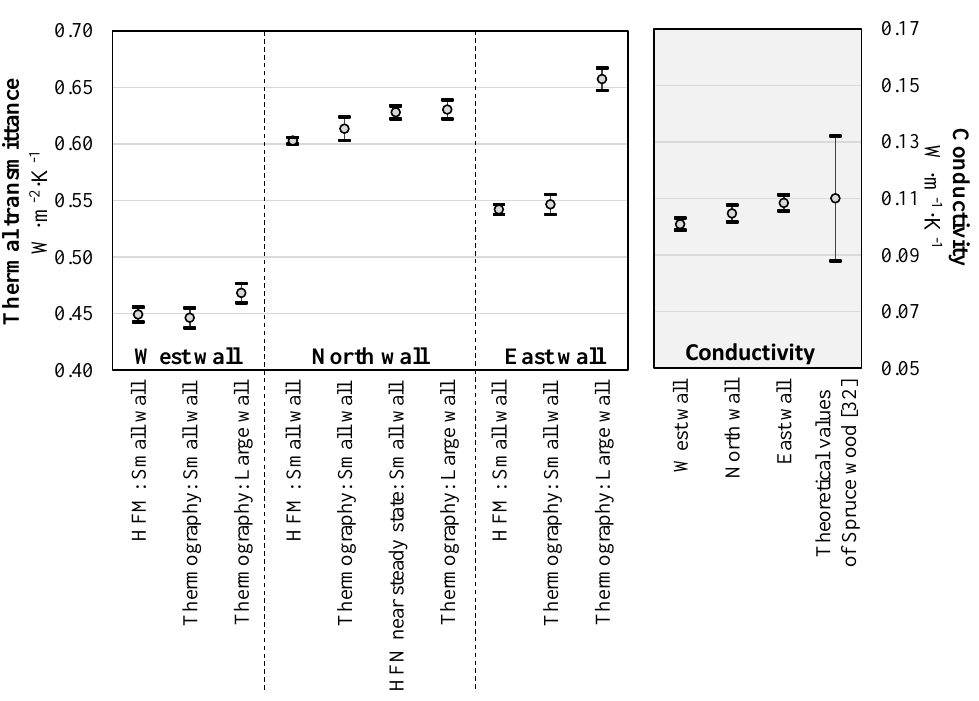
Figure 7. The thermal conductance of the west wall (left figure), north wall (centre figure), and east wall (right figure) with confidence interval of 95% certainty (red lines). The Y-axis represents the conduction heat transfer (Q Cond,Small_wall ) calculated by Equation (6). The X-axis represents the difference between the interior and exterior wall surface temperatures. The dashed lines represent 95% certainty for measurements to disperse around the mean (black trend-line).